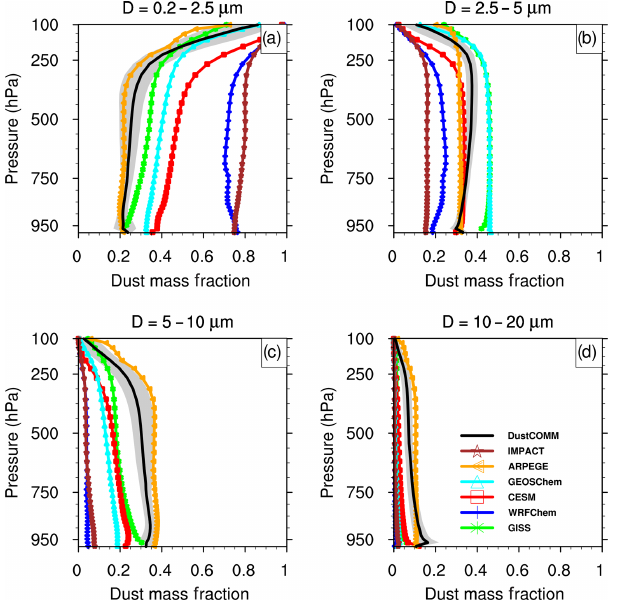
Figure 7. Vertical distributions of dust mass fractions as a function of particle size for the individual model simulation (coloured lines) and DustCOMM (black lines) estimates. The grey shading shows the 95% uncertainty confidence interval for DustCOMM.